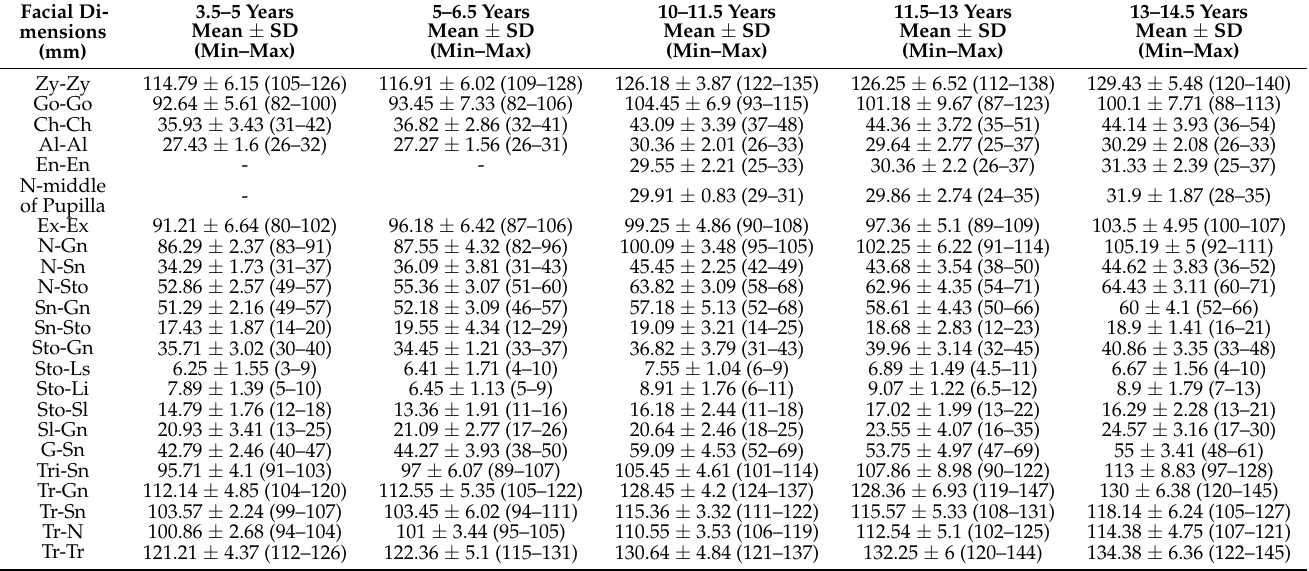
Table 2. Facial dimensions in our study on different age groups.